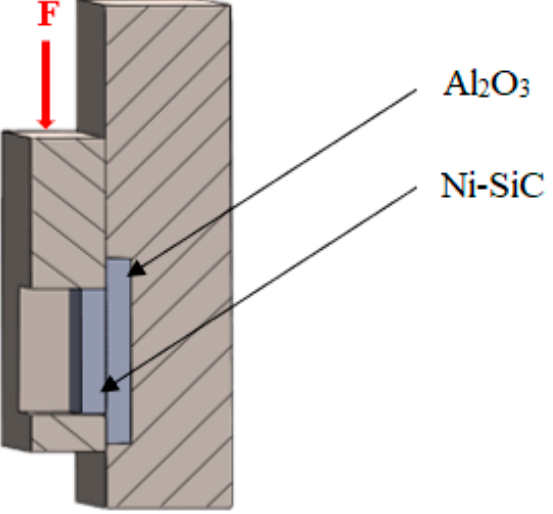
Figure 5. Schematic representation of a jig for shear strength measurement.